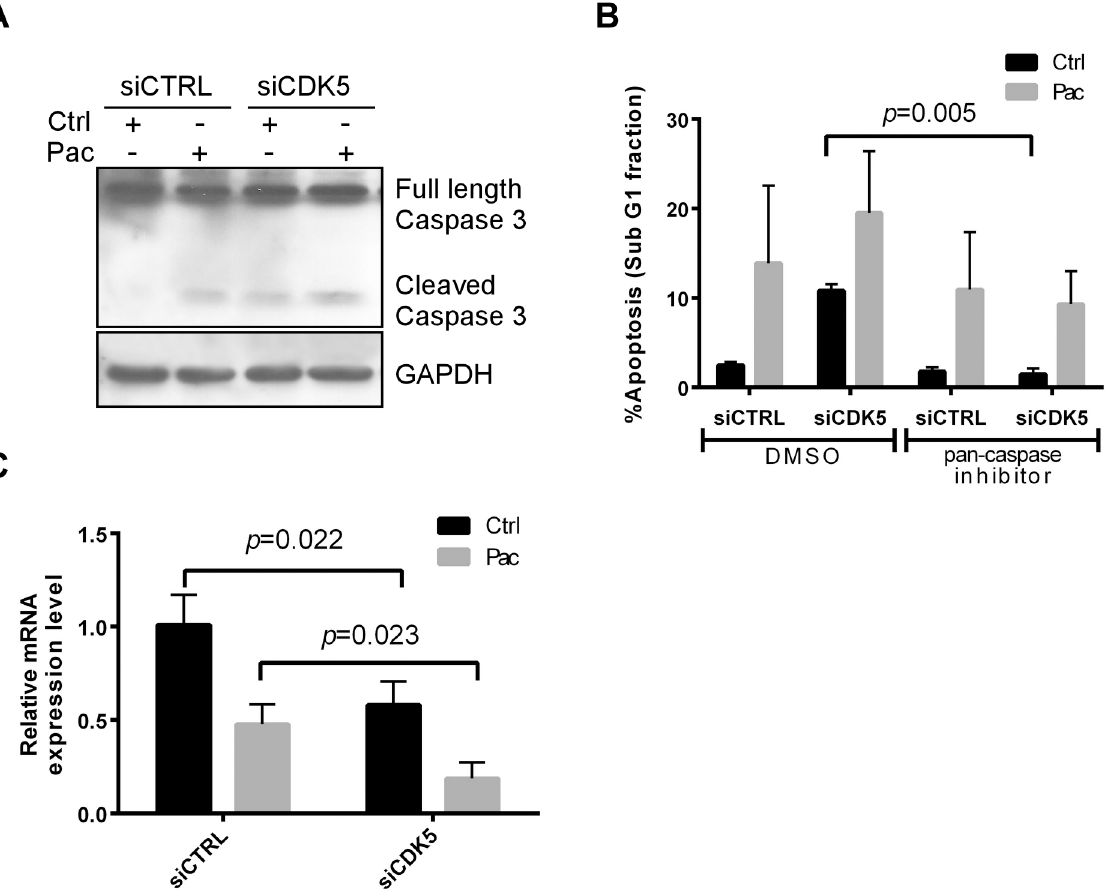
Fig 5. CDK5 knockdown induces caspase-mediated apoptosis and downregulates Bcl-2. ( A ) CDK5 knockdown induced caspase-3 activation in the presence and absence of paclitaxel. HEY cells were transfected with control siRNA or CDK5 siRNA for 24 h, treated with paclitaxel (3 nM) or diluent for 48 h, lysed and total protein analyzed by immunoblot using antibodies against activated caspase-3 and GAPDH. ( B ) A pan-caspase inhibitor blocked CDK5 knockdown – induced apoptosis. HEY cells were pretreated for 2 h with 20 μ M of a pan-caspase inhibitor (Z-VAD-FMK), or negative control (Z-FA-FMK), followed by treatment for 24 h with or without paclitaxel (3 nM). The cells were then fixed in 70% ethanol, stained with propidium iodide, and subjected to cell cycle analysis by flow cytometry. The sub-G1 cell population was considered apoptotic and expressed as a percentage of the whole-cell population. ( C ) CDK5 knockdown decreased the expression of Bcl-2 mRNA. HEY cells were treated as in (A) and total RNA was extracted for real-time PCR analysis of Bcl- 2 mRNA expression. Data shown were from three independent